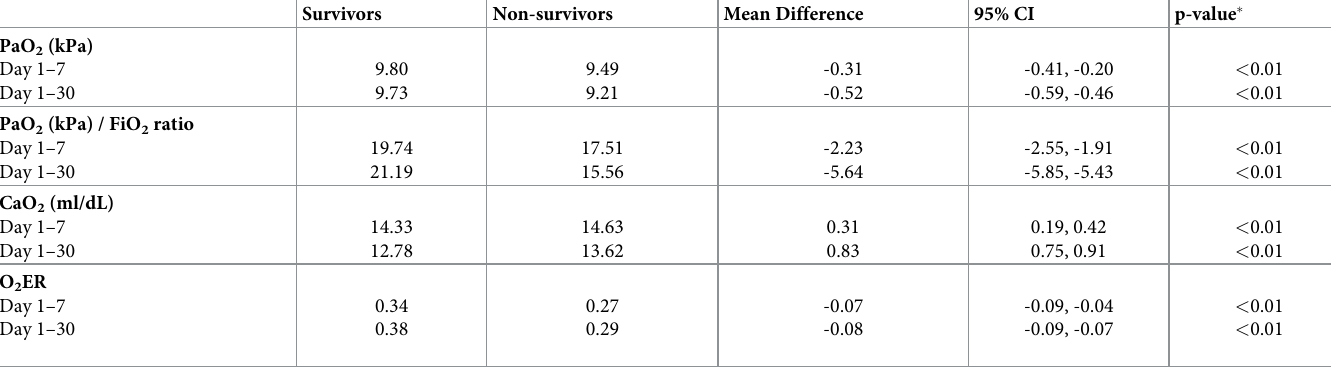
Table 2. Comparison of mean averaged blood oxygen indices at day one-seven, and day one-30; survivors (n = 133) vs. non-survivors (n = 51).